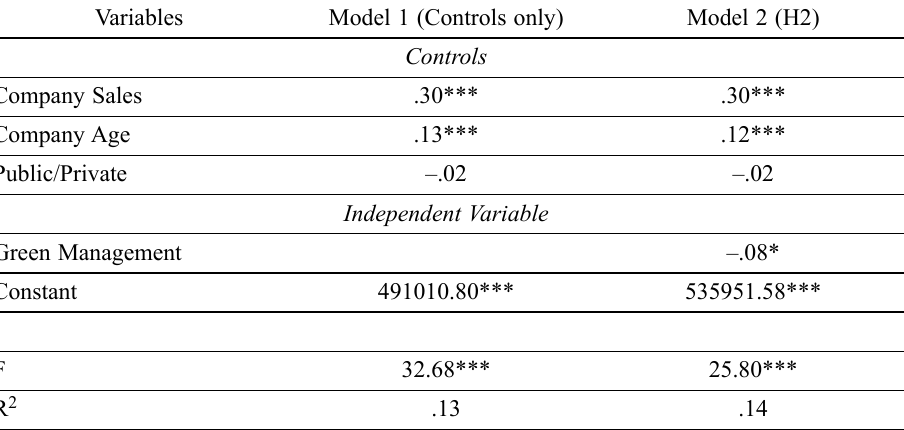
Table 4. Results of the regression analysis for CEO base pay ( N = 659)